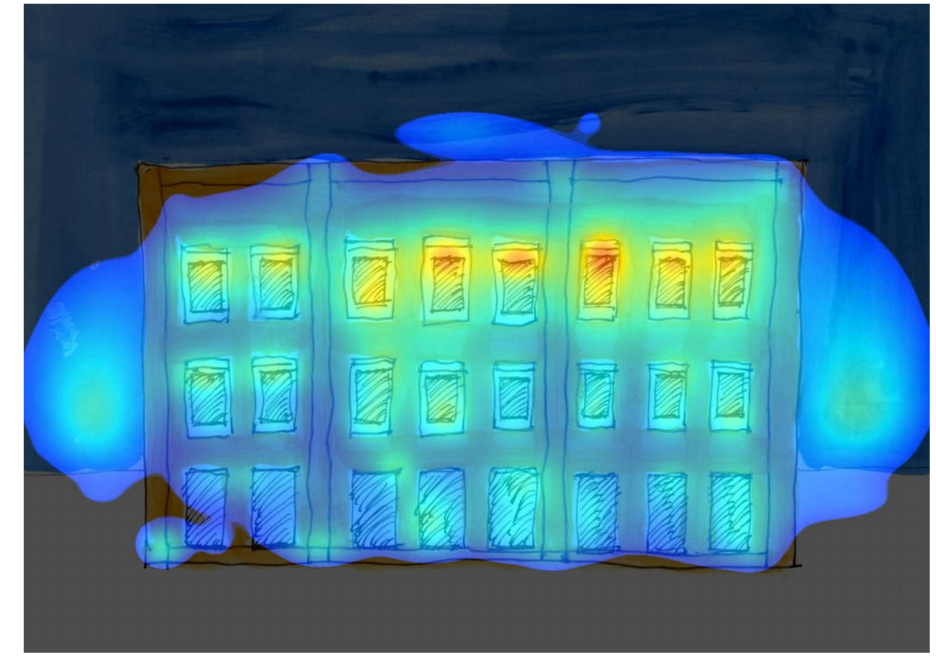
Figure 2. Heat map for Classical / Baroque